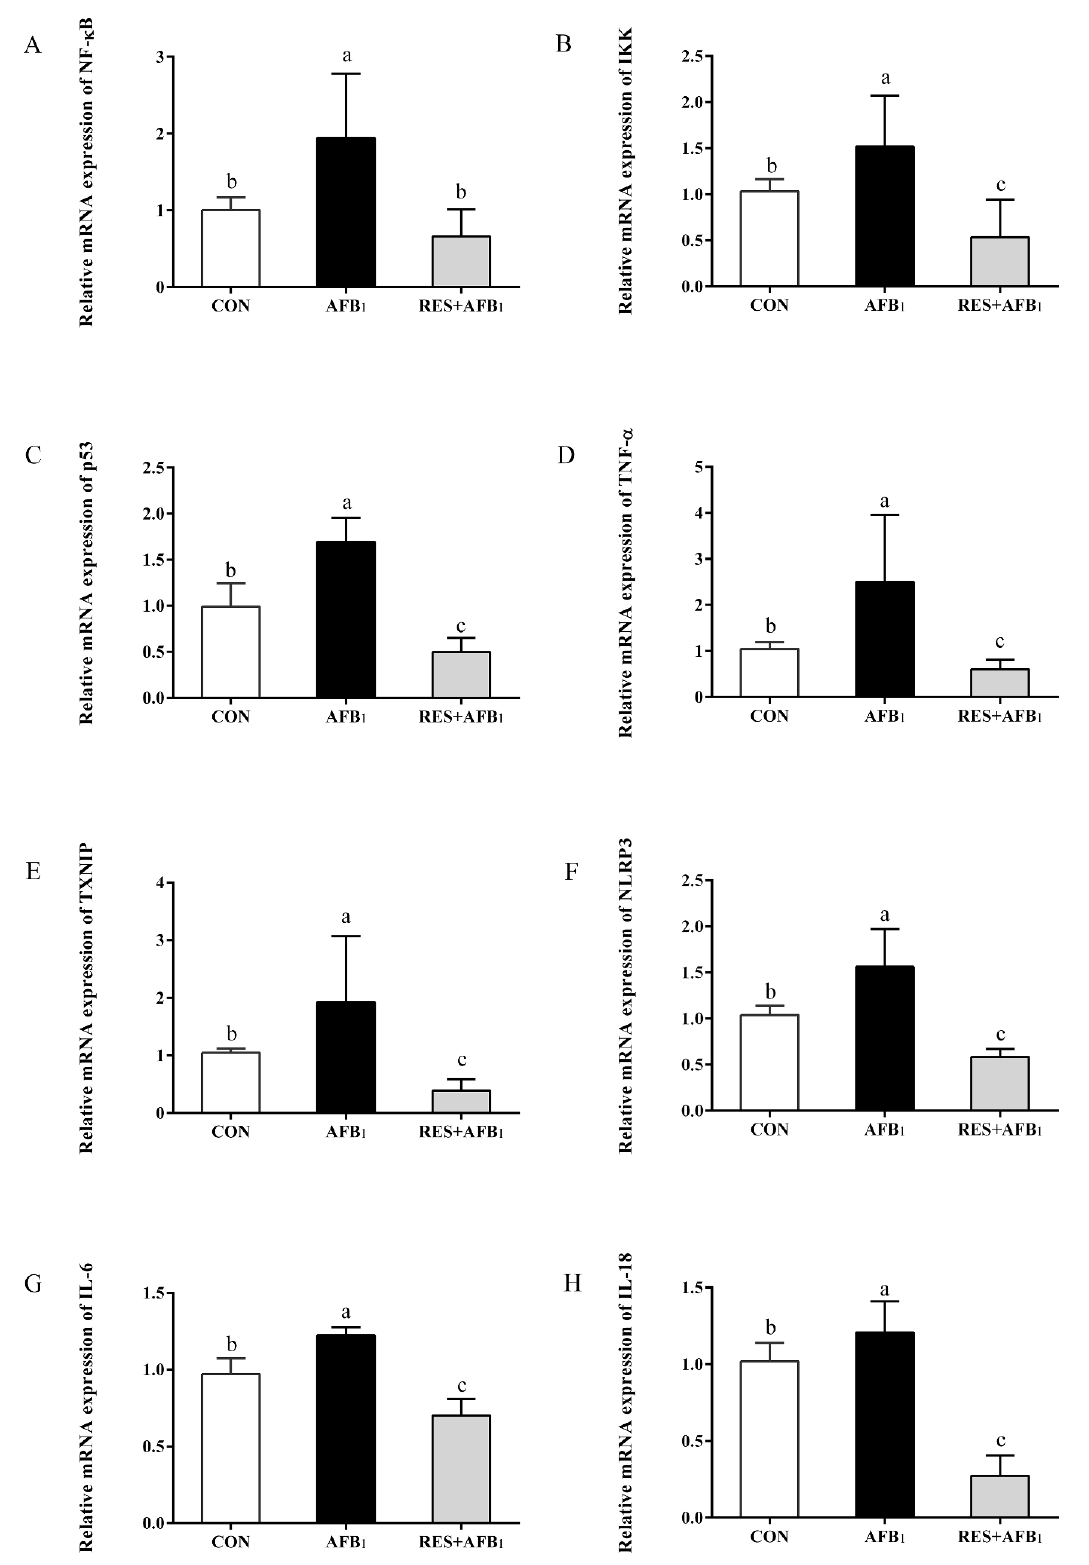
Figure 5. ( A – H ) Effect of RES on the mRNA expression levels of antioxidant genes in the ileum of AFB 1 -exposed duck. Values are expressed as mean ± SD, n = 8. Labeled (a, b, c, a > b > c) means in a row without a common letter differ, p < 0.05. IKK: Inhibitor of nuclear factor kappa-B kinase; p53: p53 tumor suppressor protein; TNF- α : Tumor necrosis factor- α ; IL-6: Interleukin-6; IL-18: